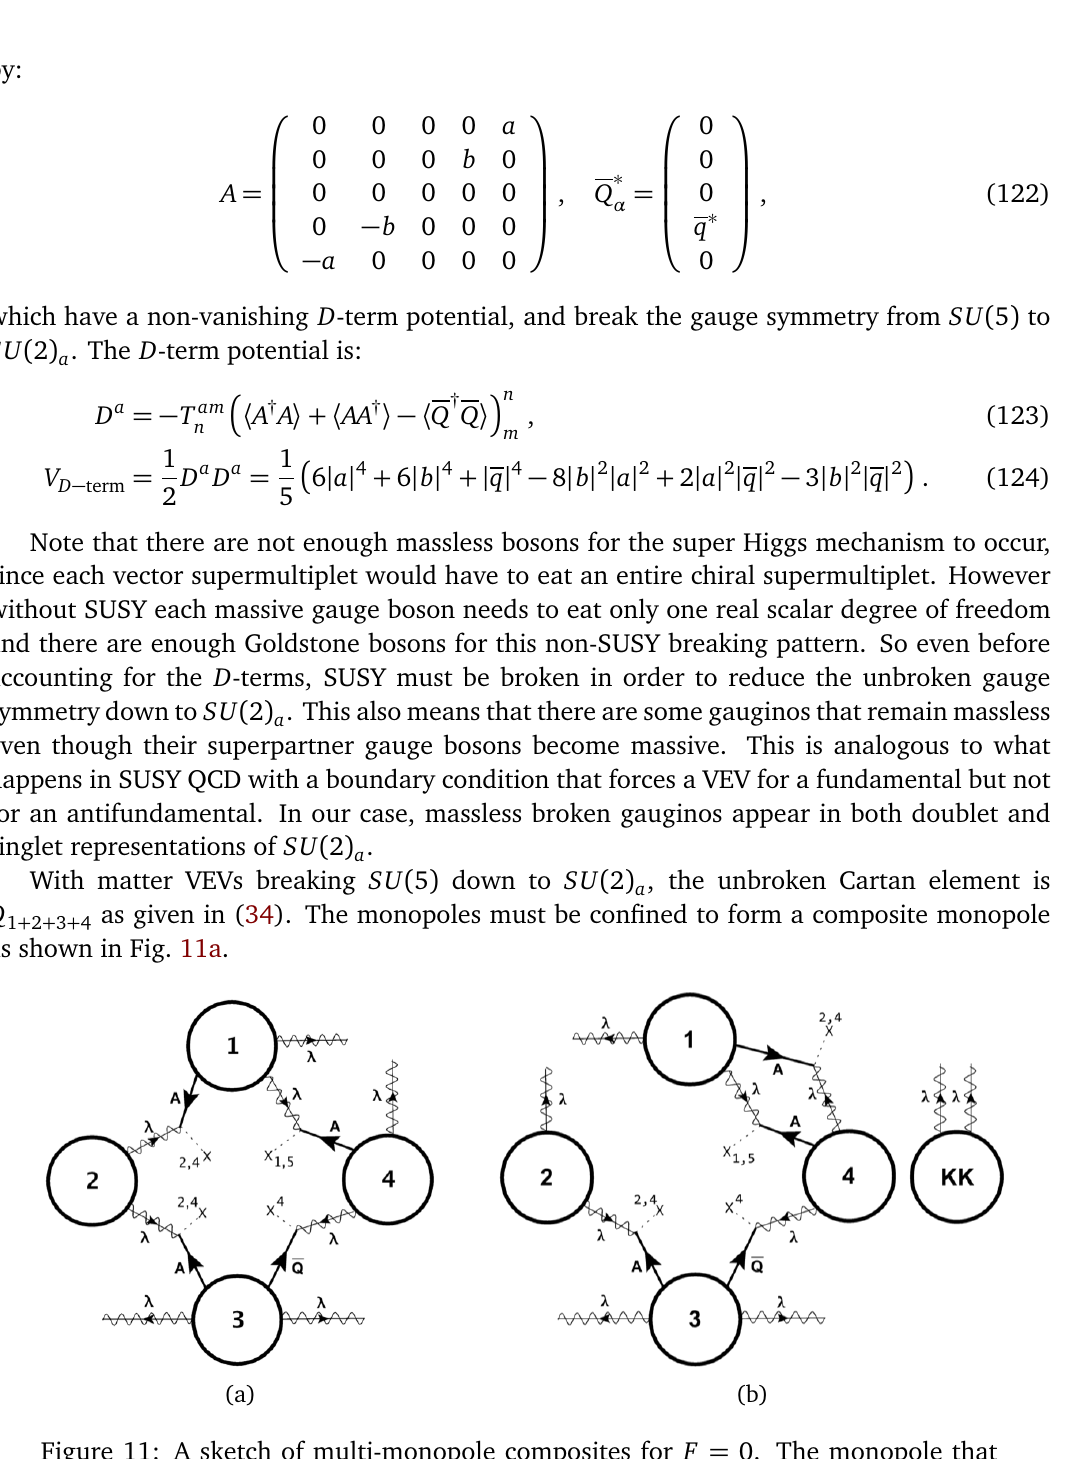
Figure 11: A sketch of multi-monopole composites for F = 0. The monopole that generates the ‘t Hooft vertex (126) is shown in (a) and the composite that generates the ‘t Hooft vertex (128) is shown in (b). The antisymmetric and squark VEVs, (122), are represented as a cross with their color indices. Two of the gaugino zero modes in (b) remain massless even though their superpartner gauge bosons are massive. Note the the KK monopole can form a bound state with the 1-4 composite, as in Sec. 4. This gauge breaking pattern produces a variety of elementary and composite